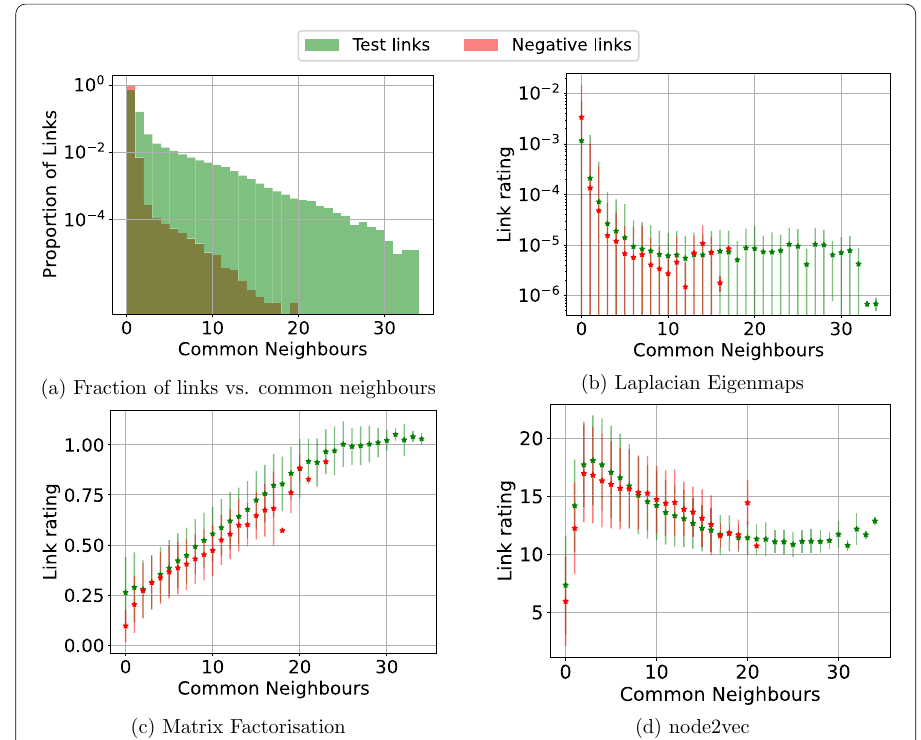
Fig. 6 a Fraction of links of the Maayan‑Vidal network (rewired C = 0.20 ) that share a given number of neighbours. Average rating of negative and test links with a given number of common neighbours derived by b Laplacian Eigenmaps, c Matrix Factorisation, and d node2vec